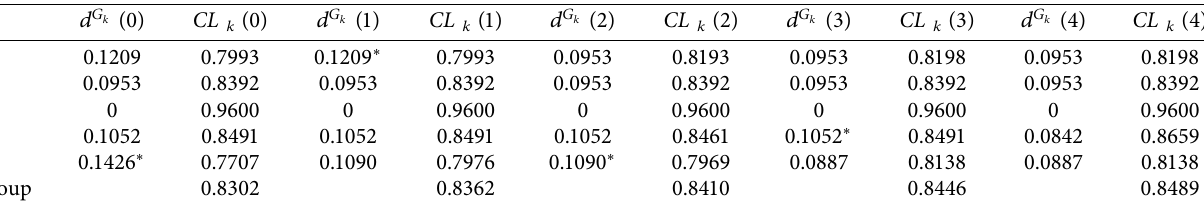
Table 7: .e adjustment process of the consensus level.